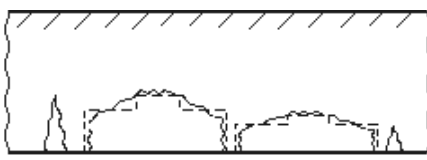
Fig 3. Merge of micro racks into local cavities